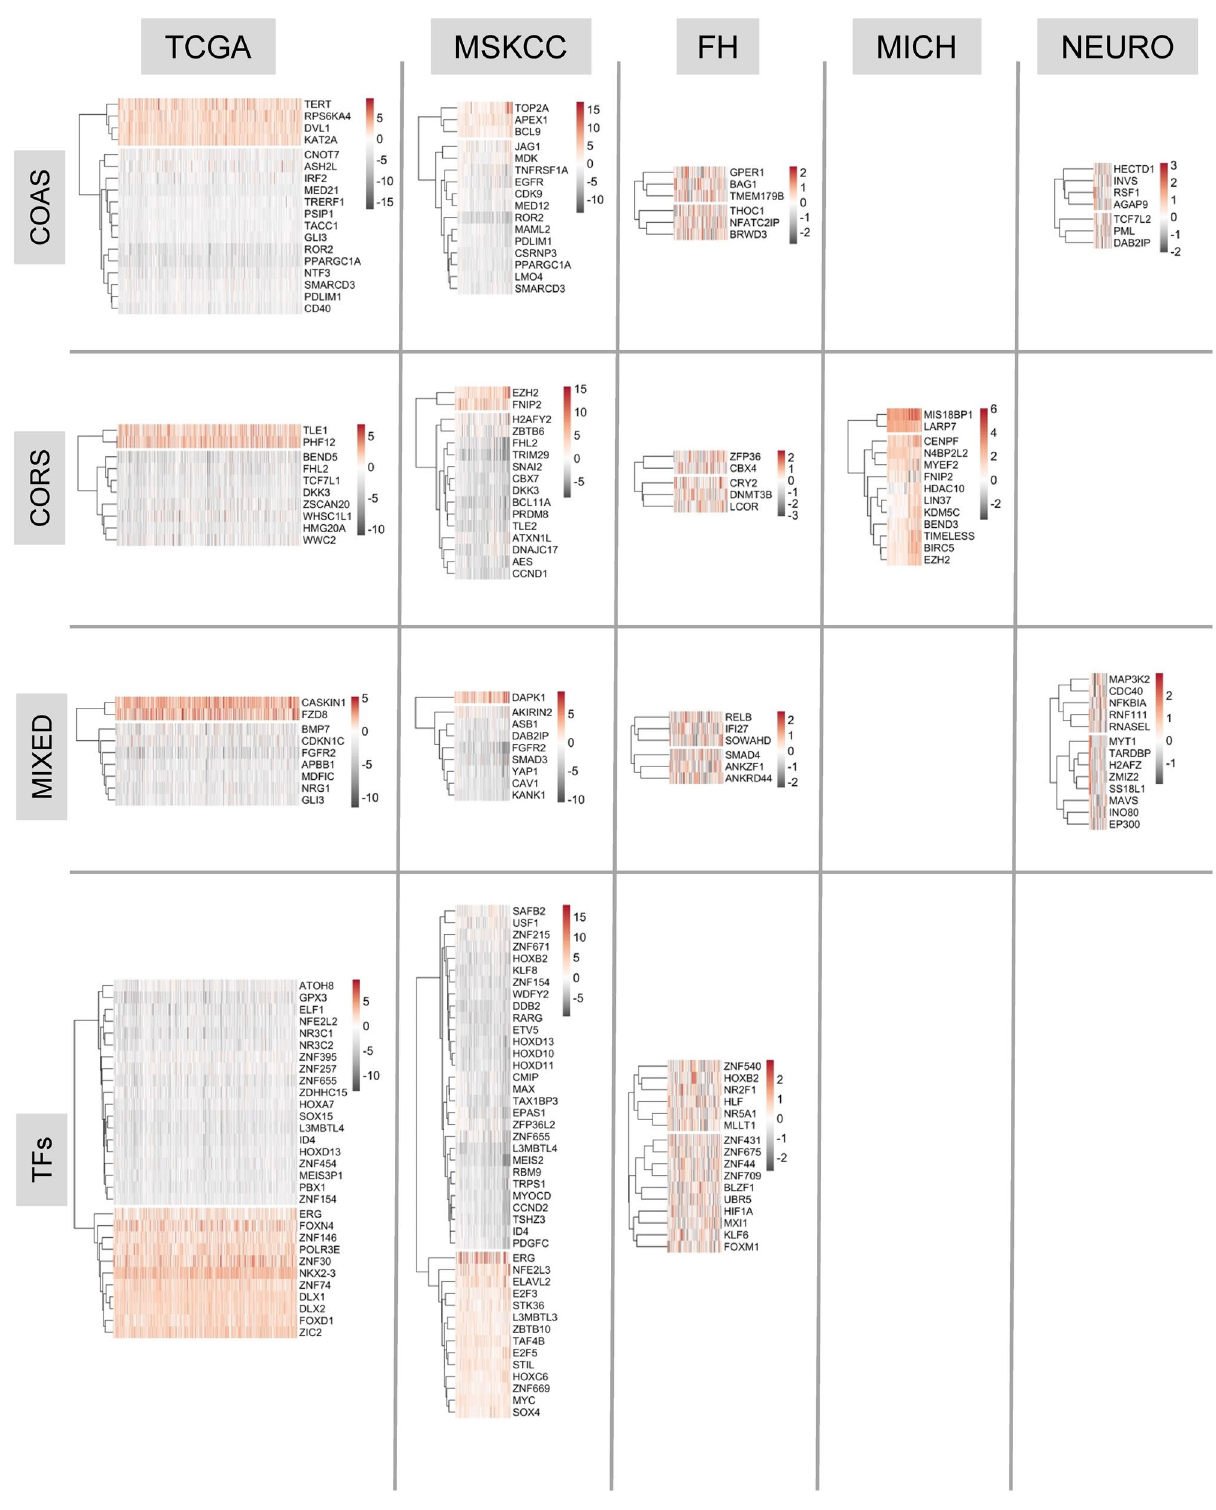
Figure 2. Expression of transcription factors (TFs), coactivators (COAS), corepressors (CORS) and mixed function coregulators (MIXED) in PCa cohorts. Genes in each group were filtered (genefilter; > 2.5 Z scores in 35% tumors) to reveal the most frequently and strongly altered and genes and tumors (columns) were visualized